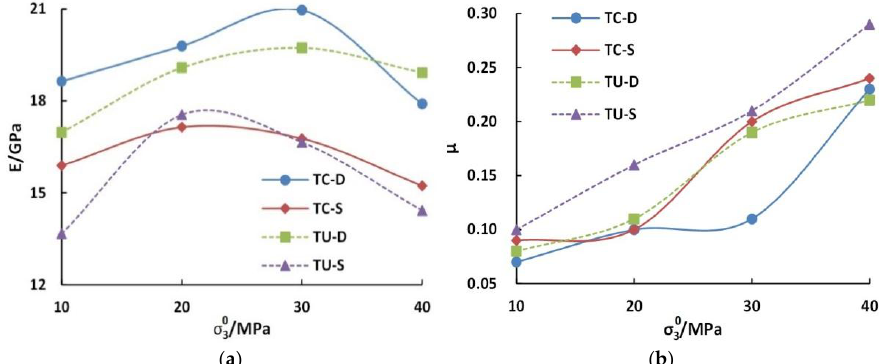
Figure 4. Variation of the deformation parameters of sandstone with the initial confining pressure ( a ) Young’s modulus; and ( b ) Poisson′s ratio.